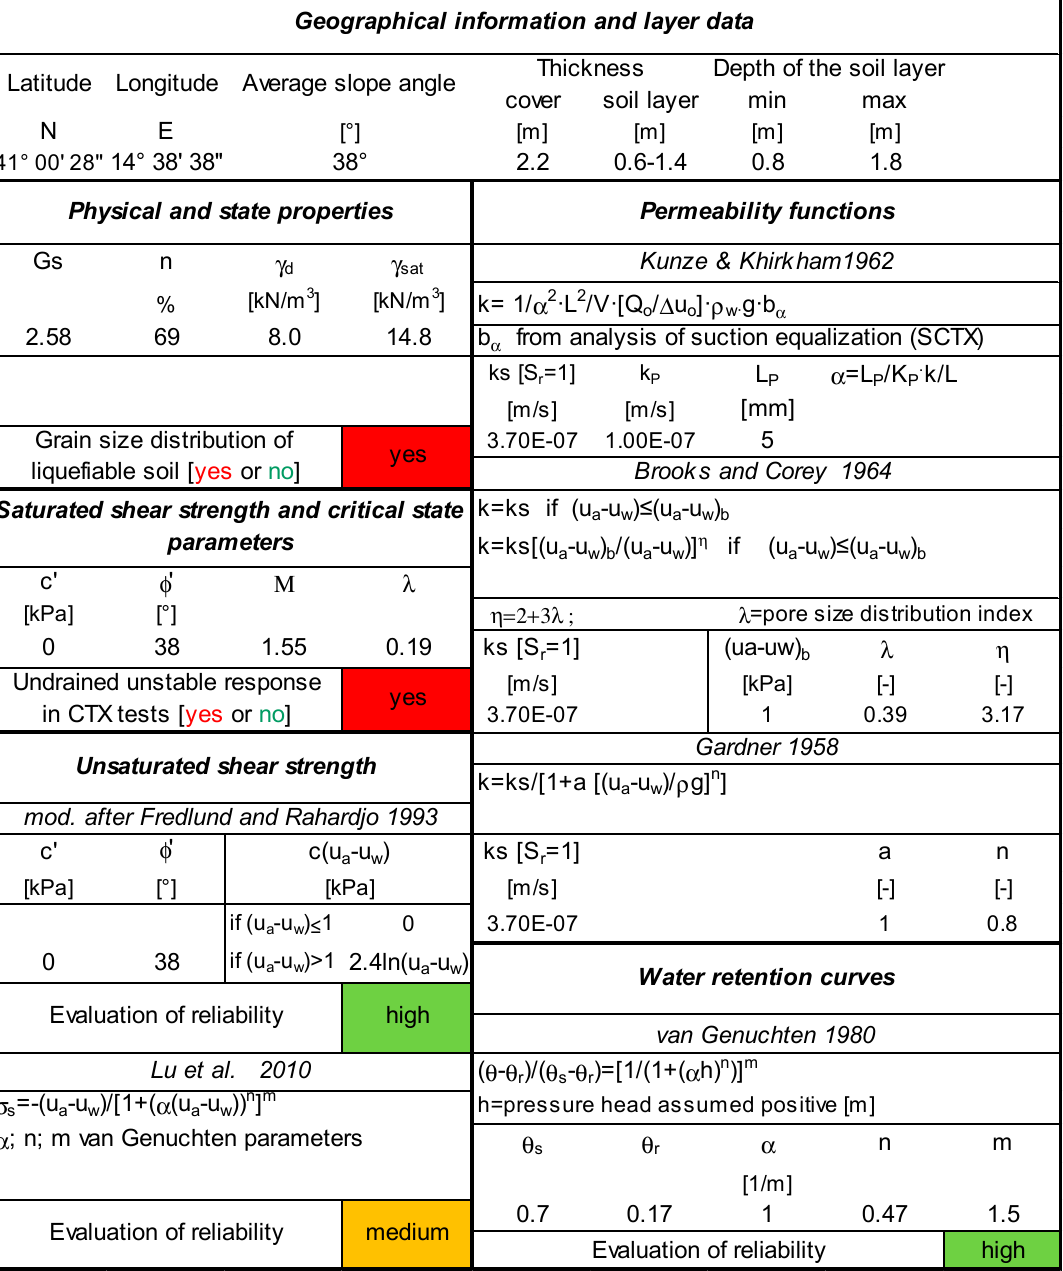
very steep slope (i.e., slope angle significantly larger than the friction